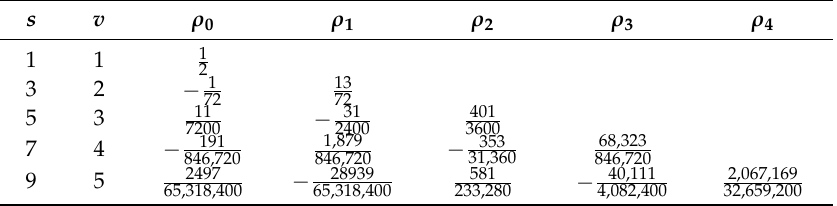
Table 6. Coefficients of extended trapezoidal rules of the first kind (ETR 1 ) using uniform